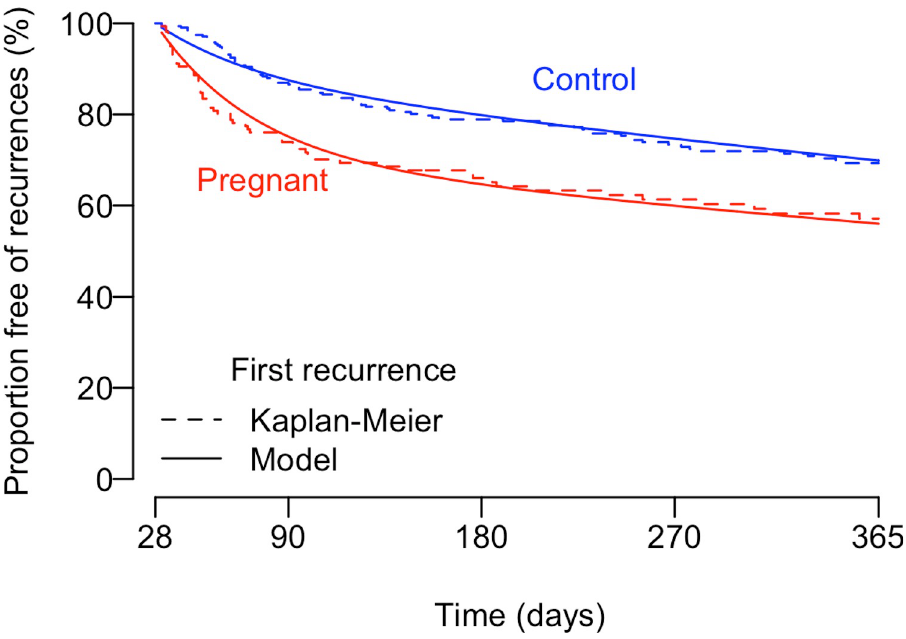
Fig 3. Fitting of the mathematical model (Eqs 1 and 2) to the time to the first P . vivax recurrence over 1-year follow-up in PQ-untreated pregnant women and PQ-treated non-pregnant controls.